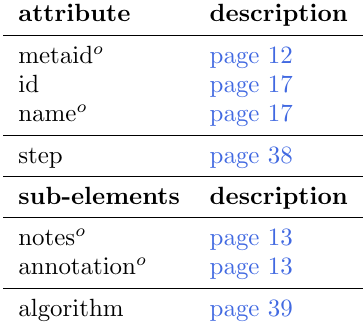
Listing 2.38 shows the use of the oneStep